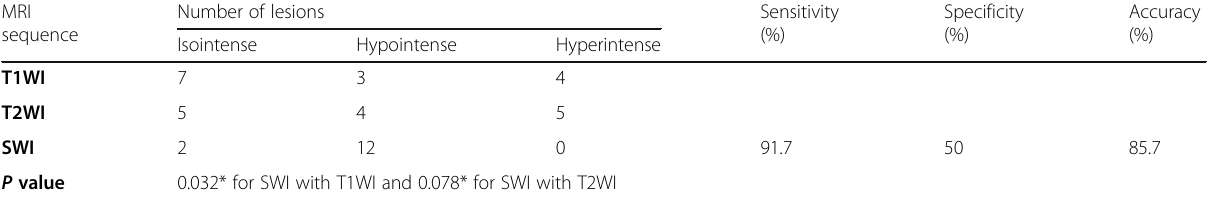
Table 3 T1WI, T2WI, and SWI lesion signal intensity of the calcification (number of patients = 14) MRI sequence